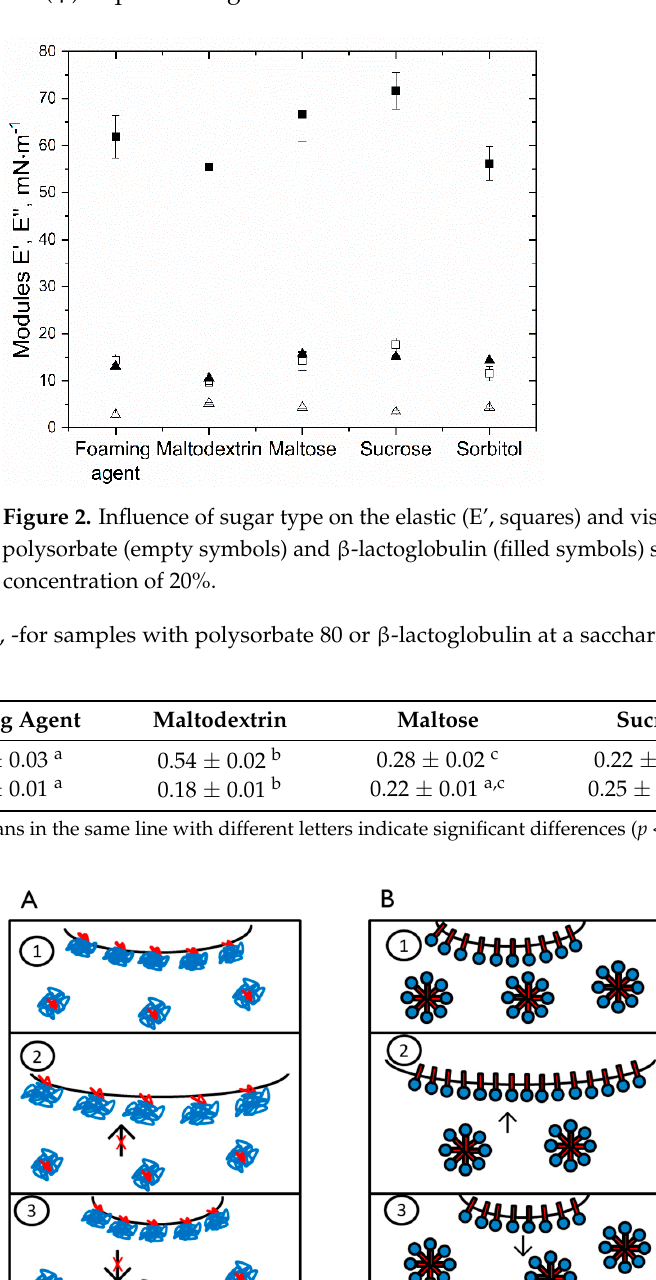
Table 3. Calculated tan ( φ ), -for samples with polysorbate 80 or β -lactoglobulin at a saccharide con- centration of 20% at 20 °C Foaming Agent Maltodextrin